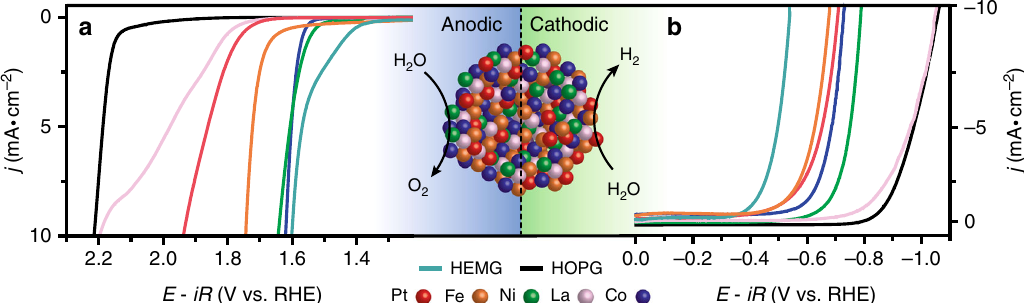
Fig. 4 Electrocatalytic evaluation of a CoFeLaNiPt HEMG-NP electrocatalyst. a Anodic polarization of the HEMG electrocatalyst and its individual components starting from the equilibrium potential of OER, 1.23 V vs. RHE. Each material was loaded onto the HOPG substrate by nanodroplet-mediated electrodeposition. The current was converted in terms of the current density, j , based on the ECSA. b Cathodic polarization of the HEMG electrocatalyst and its individual components to drive HER starting from 0 V vs. RHE. All measurements were temperature controlled to 25 °C, purged with O 2 for OER and H 2 for HER, and iR corrected. For convenience, we represented the OER and HER on the same NP, but these two reactions are not carried out simultaneously. Source data for panels a and b are provided in the Source Data fi